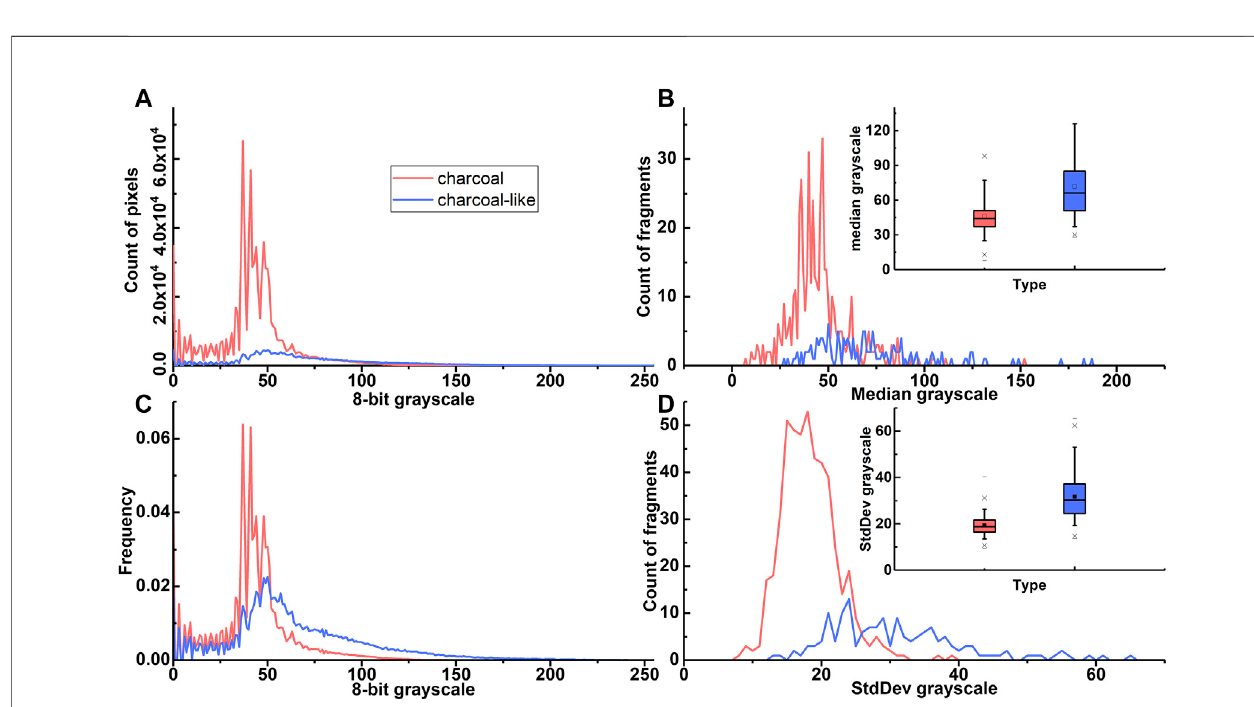
FIGURE3| Thedistinctionbetweenmicrocharcoalandmicrocharcoal-likeparticlesinatrainingsetwasmanuallyselectedfromsampleNos.10,20,30,40,50,60, and 70. (A) : histograms ofgrayscalevalues ofmicrocharcoal and microcharcoal-like pixels; (B) : thefrequency distributions ofthe grayscale values ofmicrocharcoaland microcharcoal-like pixels; (C) : the distribution of median grayscale values of microcharcoal and microcharcoal-like particles; (D) : the standard deviations of grayscale values of microcharcoal and microcharcoal-like particles.